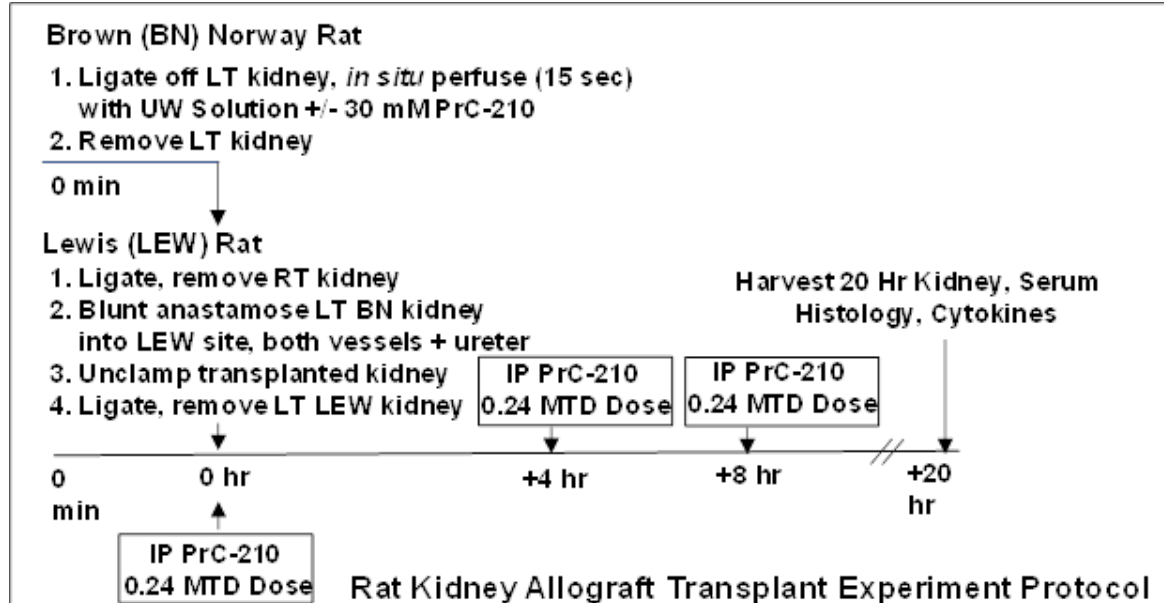
Figure 1. Experimental schematic showing surgery and PrC-210 administration times for the BN rat kidney transplants into LEW rats. LT ( left ), RT ( right ), MTD (maximum tolerated dose), and IP (intraperitoneal).